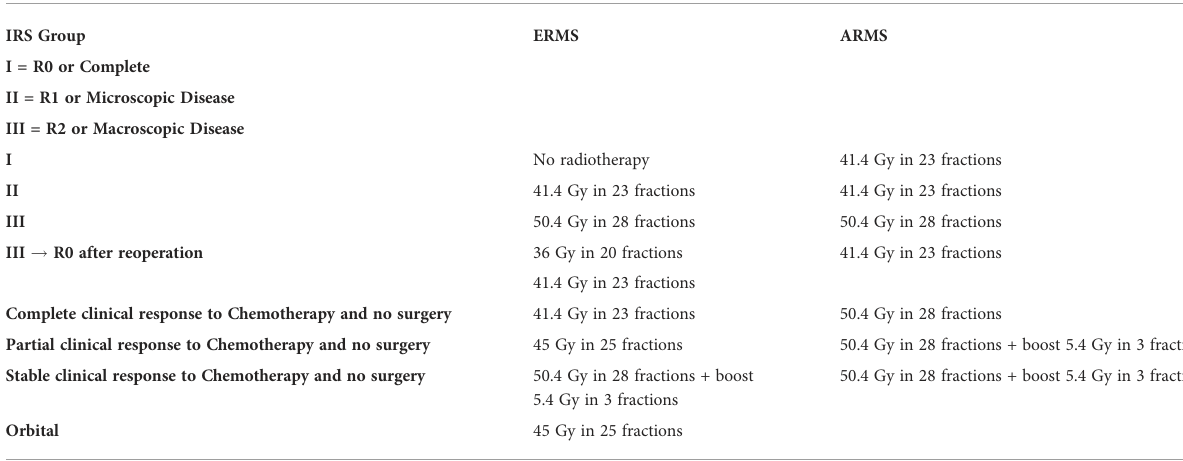
TABLE 4 Doses and fractions of radiotherapy for patients over 3 years of